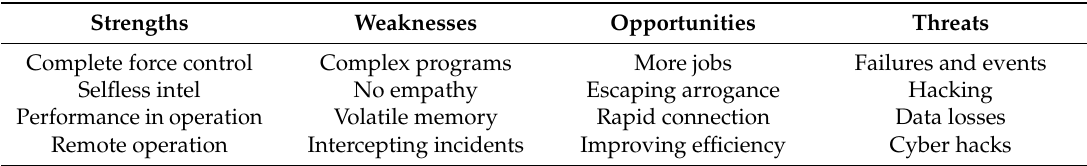
Table 2. Practical data regarding the strengths, weaknesses, opportunities, and threats (SWOT) analsise for assessing